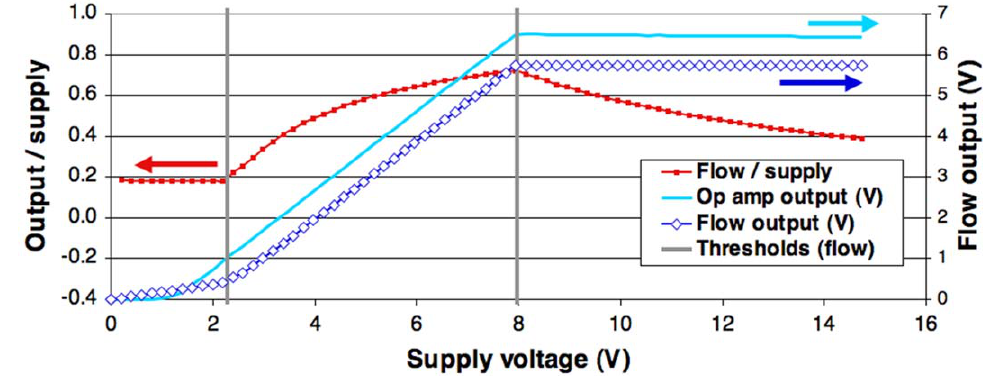
Figure 12. Flow sensor voltage output vs. supply voltage for a fixed flow, showing three different behavior